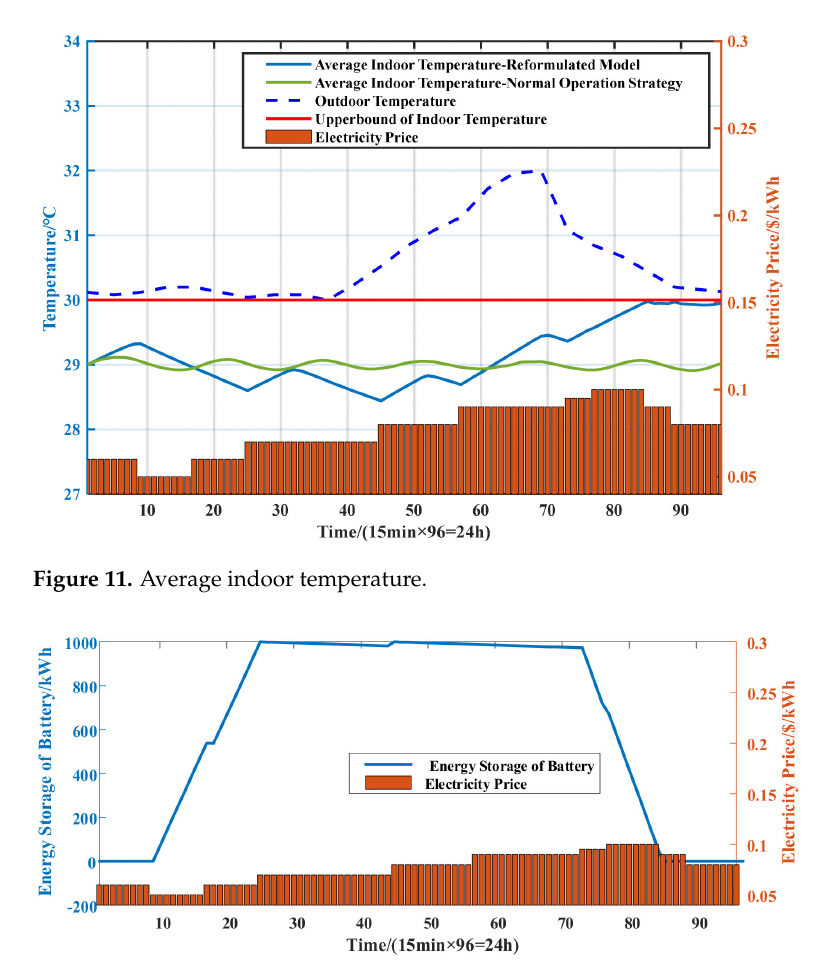
Figure 12. Energy storage of backup batteries in the 5G macro BS